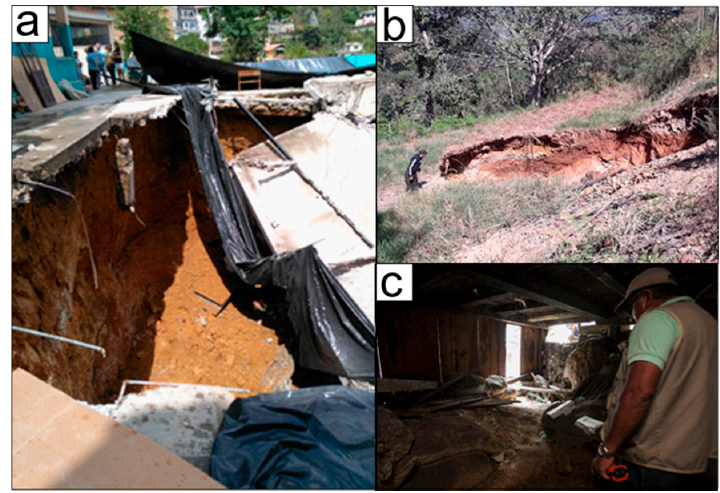
Figure 2. ( a ) Sinkhole near the school “Inmaculada Fe y Alegria” [26]; ( b ) subsidence in Zaruma [27]; ( c ) tunnel under city patrimonial zone [28] .